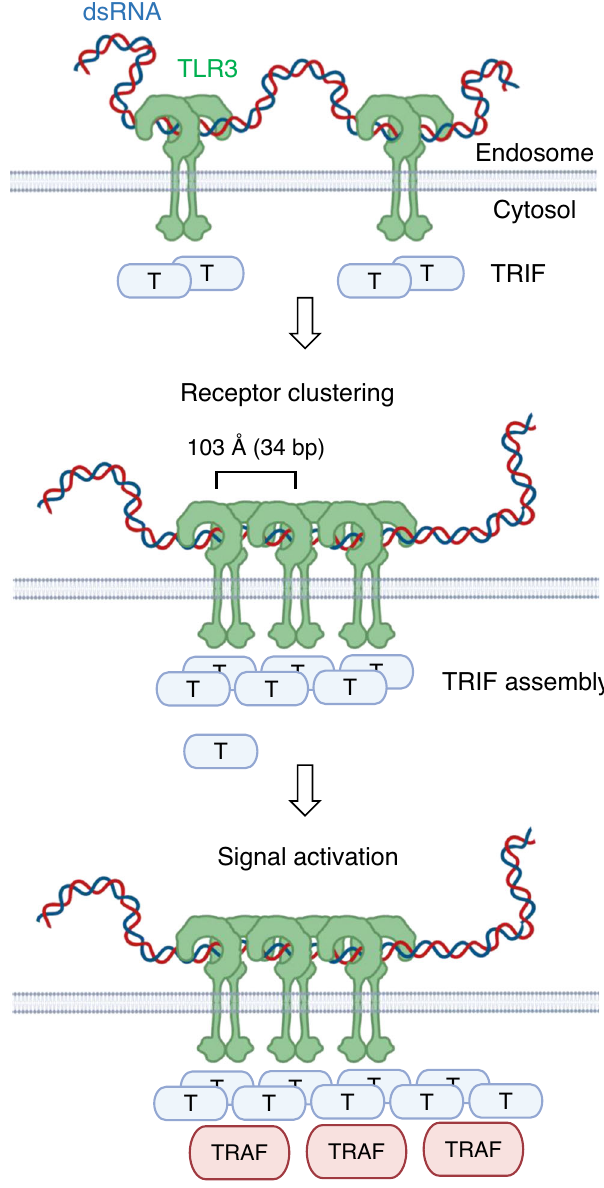
Fig. 6 | A model of TLR3 activation. TLR3 binds to dsRNA and dimerizes. The dimeric TLR3s are clustered along the dsRNA strands. Receptor clustering triggers the assembly of TRIF as a linear cluster and recruits downstream